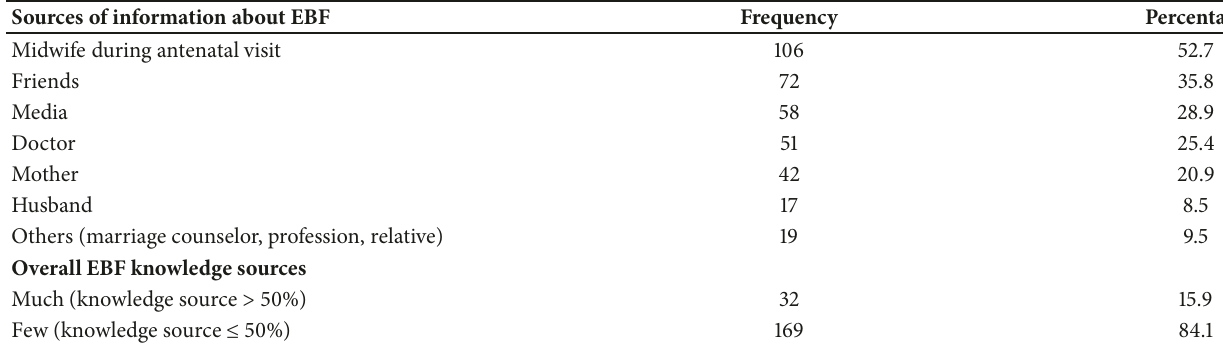
Table 3: Sources of information about exclusive breastfeeding (n =